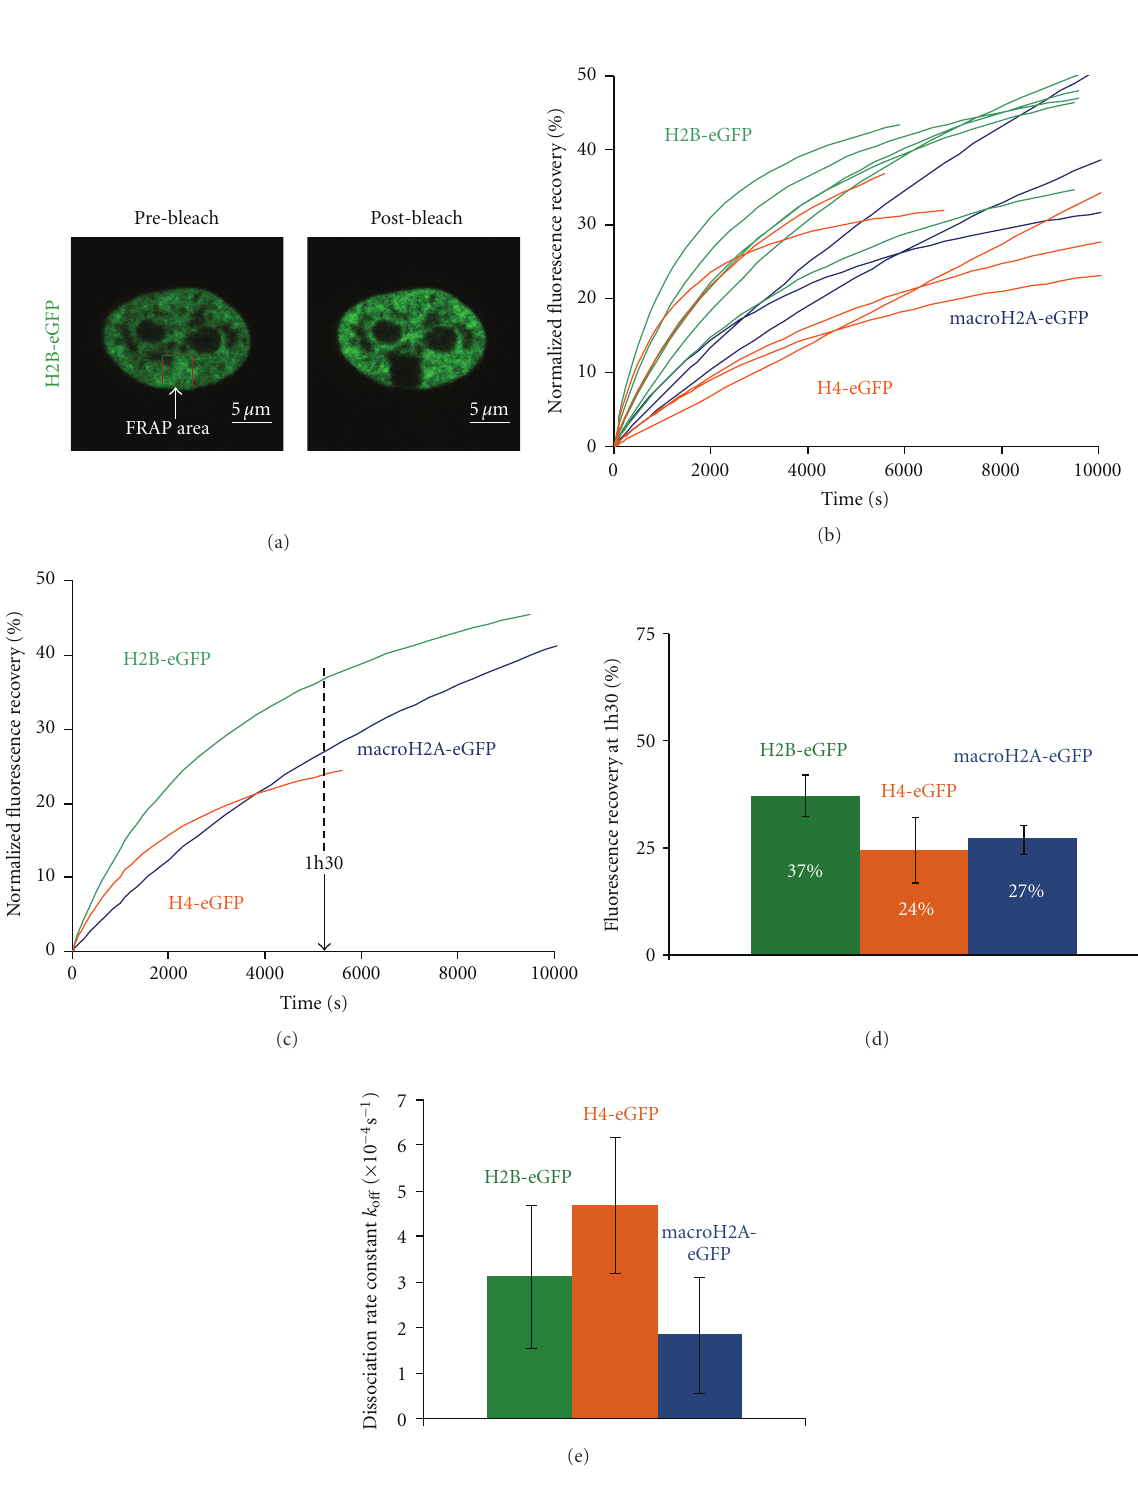
Figure 2: FRAP experiments on H2B-eGFP, H4-eGFP, and macroH2A-eGFP in nucleus of control untransfected cells. (a) Example of photobleaching on H2B-eGFP and nucleolin-mCherry stable cell line. Scale bars represent 5 μ m. (b) Normalized fluorescence recovery (%) of H2B-eGFP (green, 6 cells), H4-eGFP (orange, 5 cells) and macroH2A-eGFP (blue, 3 cells) in the nucleoplasm compartment. Each curve represents the fluorescence recovery of a single cell. (c) Average of the normalized fluorescence curves in (b) H2B-eGFP (green), H4-eGFP (orange) and macroH2A-eGFP (blue). (d) Comparison of the percentage of fluorescence recovery at 1h30 for H2B-eGFP (green), H4-eGFP (orange) and macroH2A-eGFP (blue). (e) Dissociation rate constant values k o ff (s − 1 ) of H2B-eGFP, H4-eGFP, and